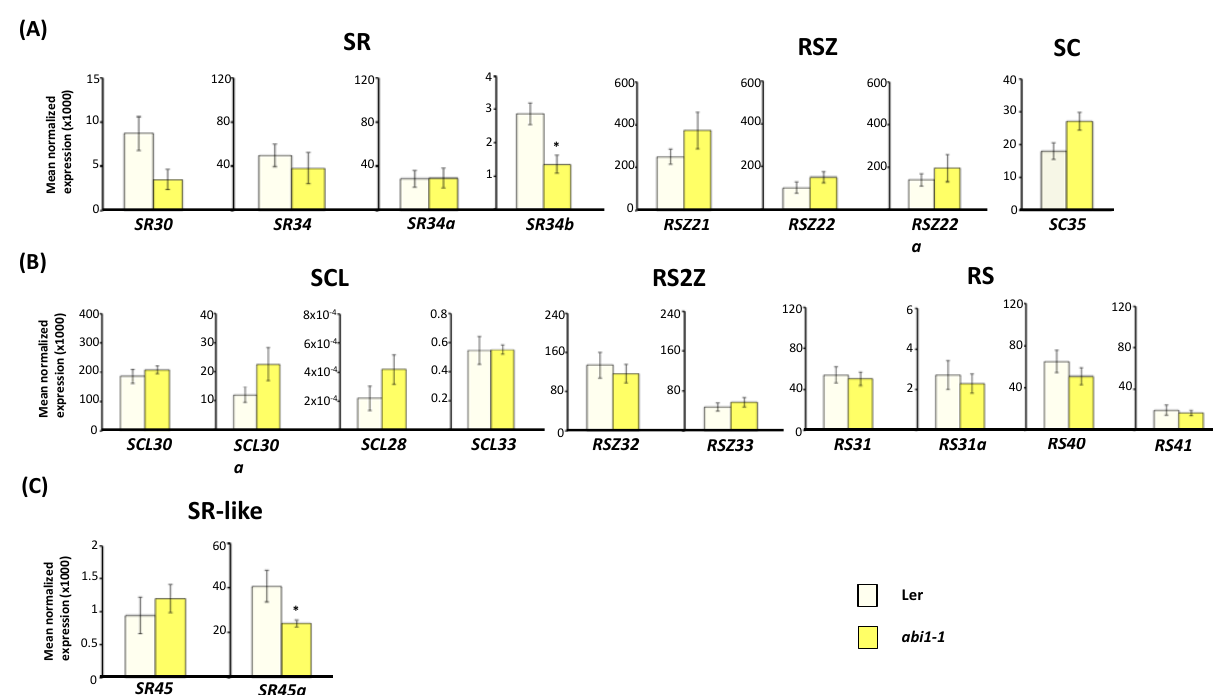
Figure 4. Expression of Arabidopsis SR and SR-like genes in the ABA-signaling abi1-1 mutant background. Real-time RT-qPCR analysis of total transcript levels of SR gene members of the mammalian ortholog ( A ) and plant-specific ( B ) subfamilies or of SR-like genes ( C ) in wild-type (L er ) and abi1-1 mutant seedlings. Results are from two independent experiments and values represent means ± SE ( n = 4). Asterisks indicate significant differences (* p < 0.05; Student’s t -test) from the corresponding wild